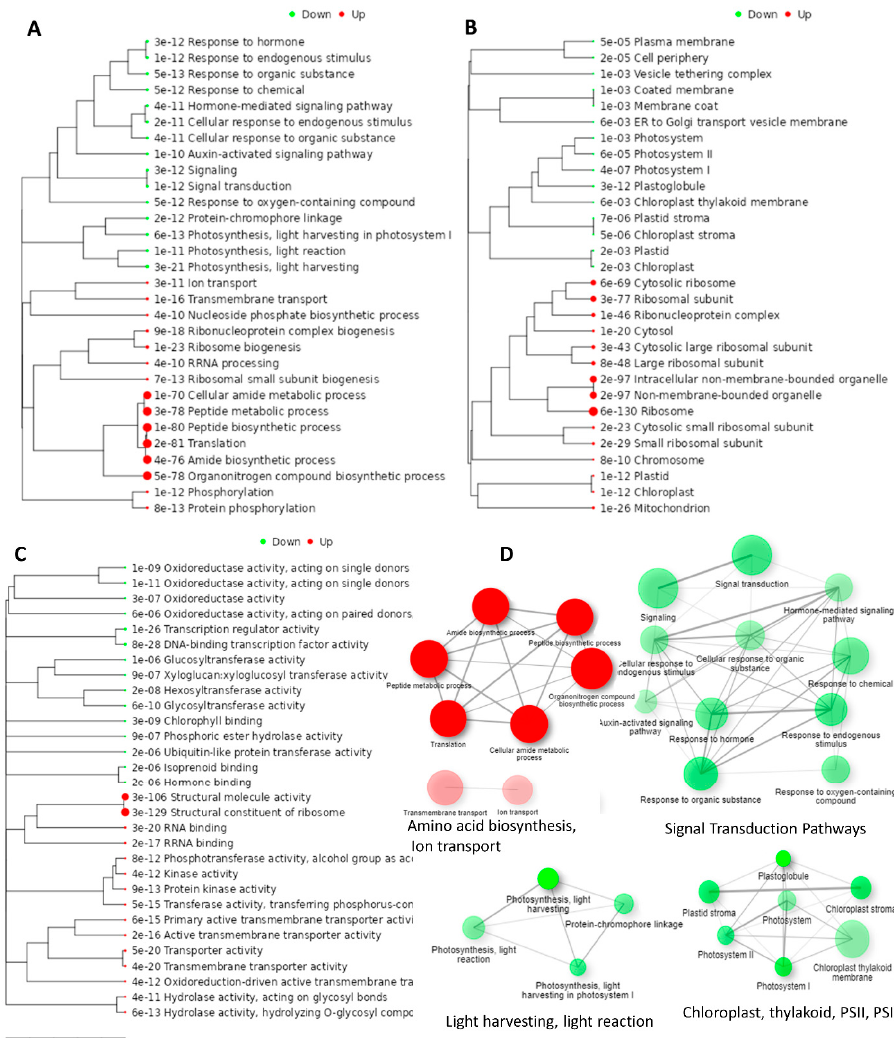
Figure 5. Hierarchical clustering tree of up-regulated and down-regulated DEGs enriched in gene ontology (GO) terms in canola ( B. napus L.) cultivar Oscar when subjected to salt stress. The 2000 most variable genes were included with number of clusters normalized by gene-mean center. ( A ) GO biological processes; ( B ) GO cellular processes; ( C ) GO molecular functions associated with DEGs; and ( D ) network interaction analysis of GO terms that were up-regulated DEGs (Red nodes and edges) and down-regulated DEGs (green nodes and edges) enriched in GO biological process, cellular component and molecular